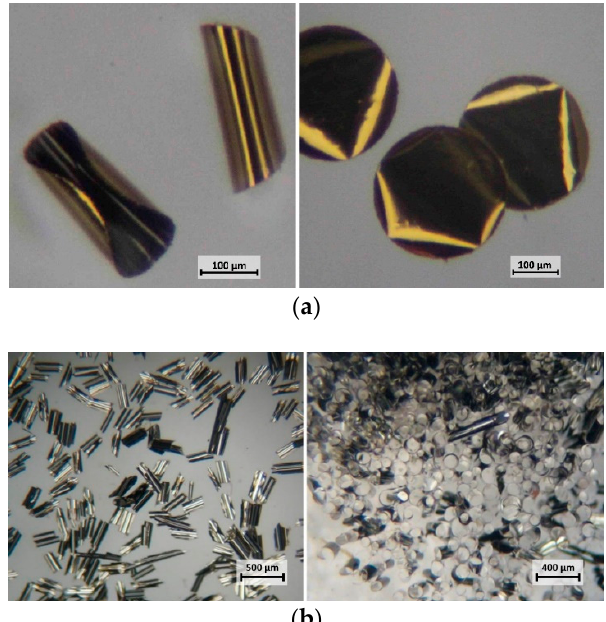
Figure 3. ( a ) Au/Ni round platelets (300 μ m, on the left) – large bi-metallic platelets tend to fold into cylinders. For comparison, on the right, purely gold platelets of the same size and shape. ( b ) 300 μ m square Ag/Ni platelets. Left – after release; right – oriented by a permanent magnet.